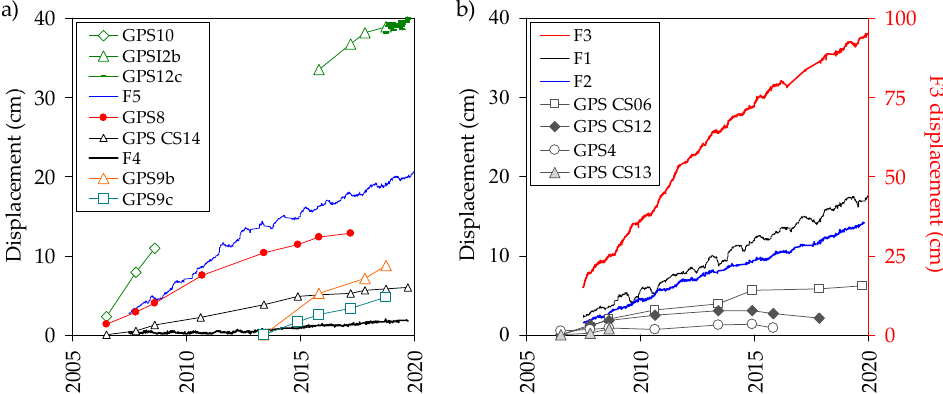
Figure 10. Displacements of GPS stations and benchmarks of Costa della Gaveta ( a ) and Varco d’Izzo ( b ) earthflows.